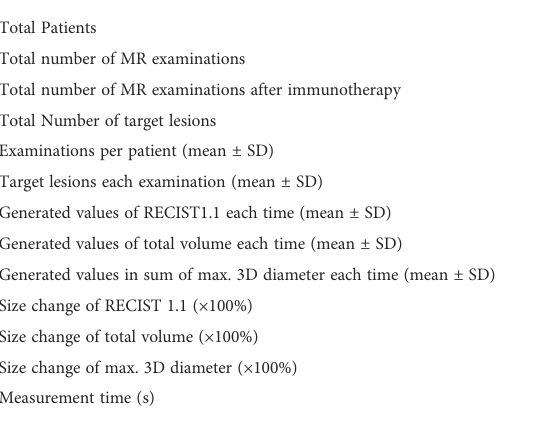
TABLE 4 Detailed information of measurements.